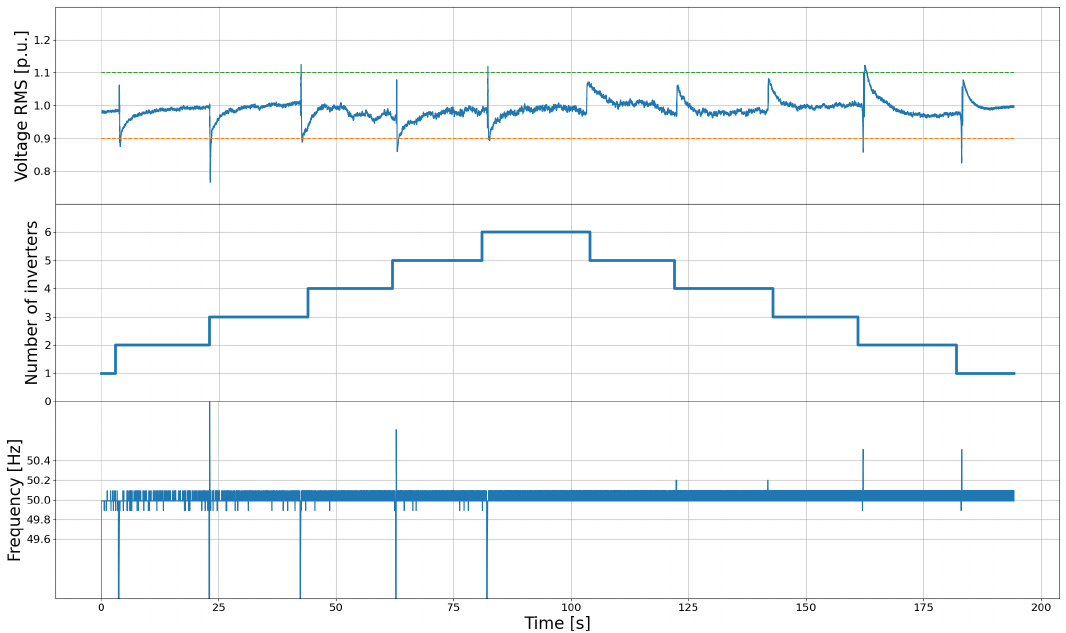
Figure 8. The sequence of connection and removal following inverters.